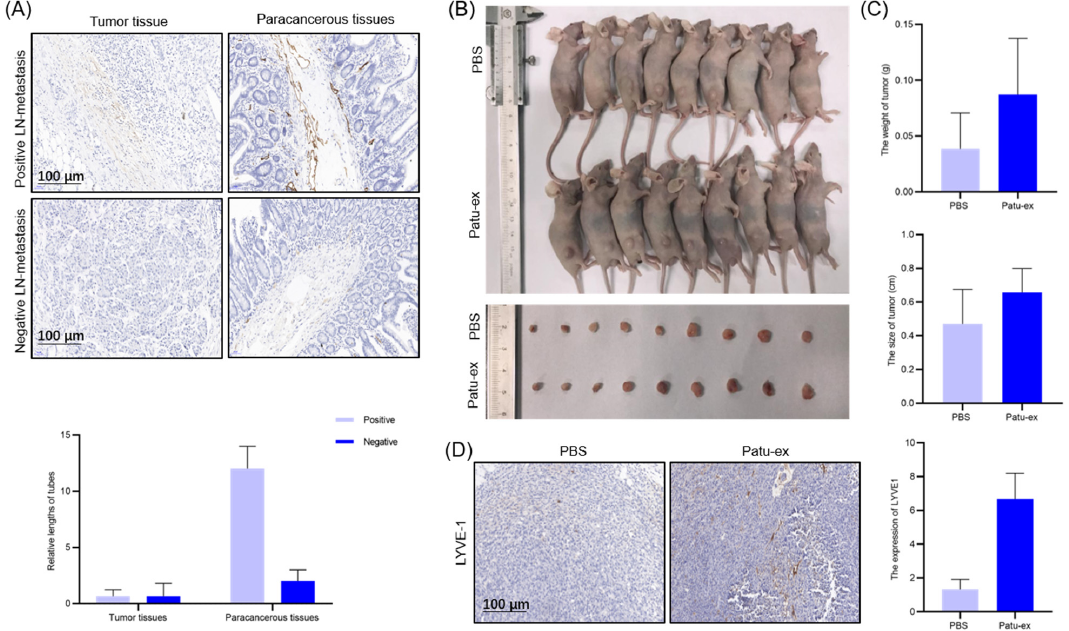
Figure 7. Exosomes from pancreatic cancer cells enhance the proliferation and lymphangiogenesis